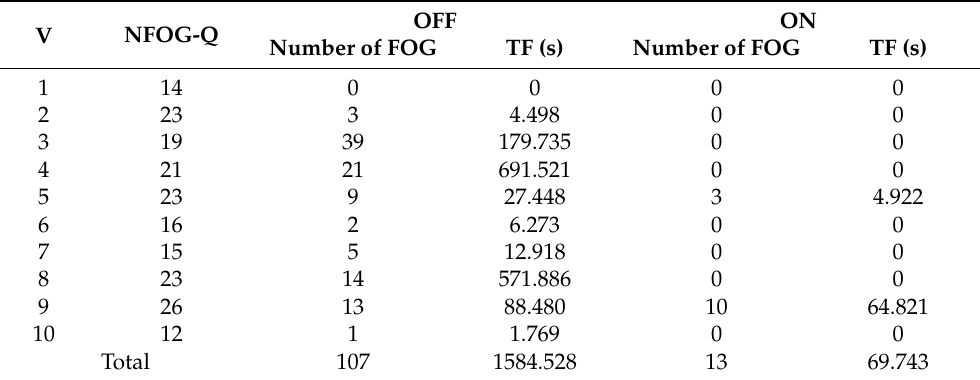
Table 6. Information about the NFOG-Q score and the total number of FOG episodes considering the sum of events in the mobility motor task and the dual task.